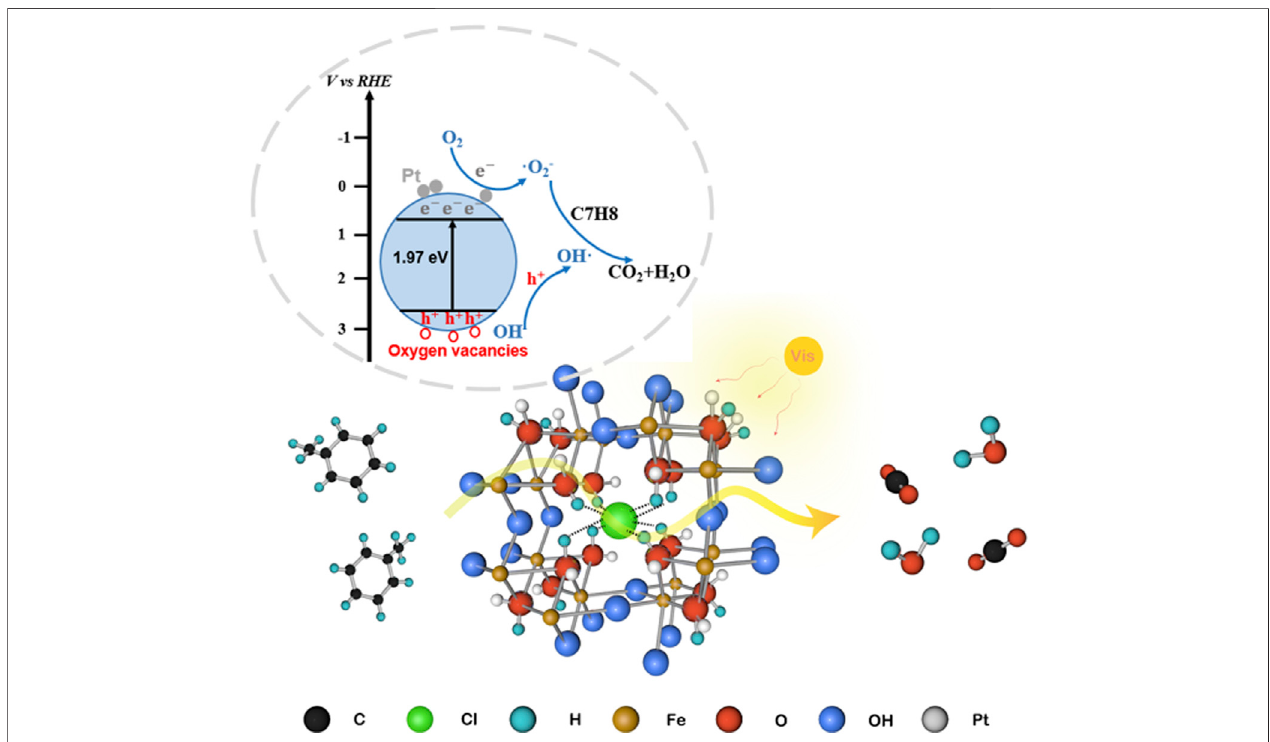
FIGURE 11 | Schematic representation of the photocatalysis mechanism